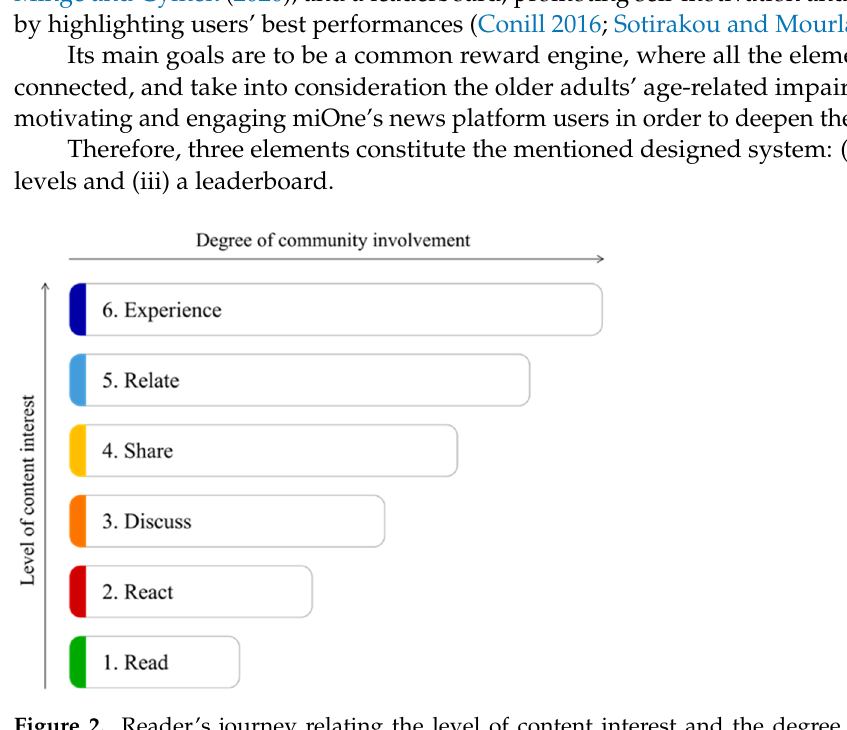
Table 3. Description of the awards. Retrieved from Gamifying News for the miOne Online Community (Regalado 2021) . Illustration